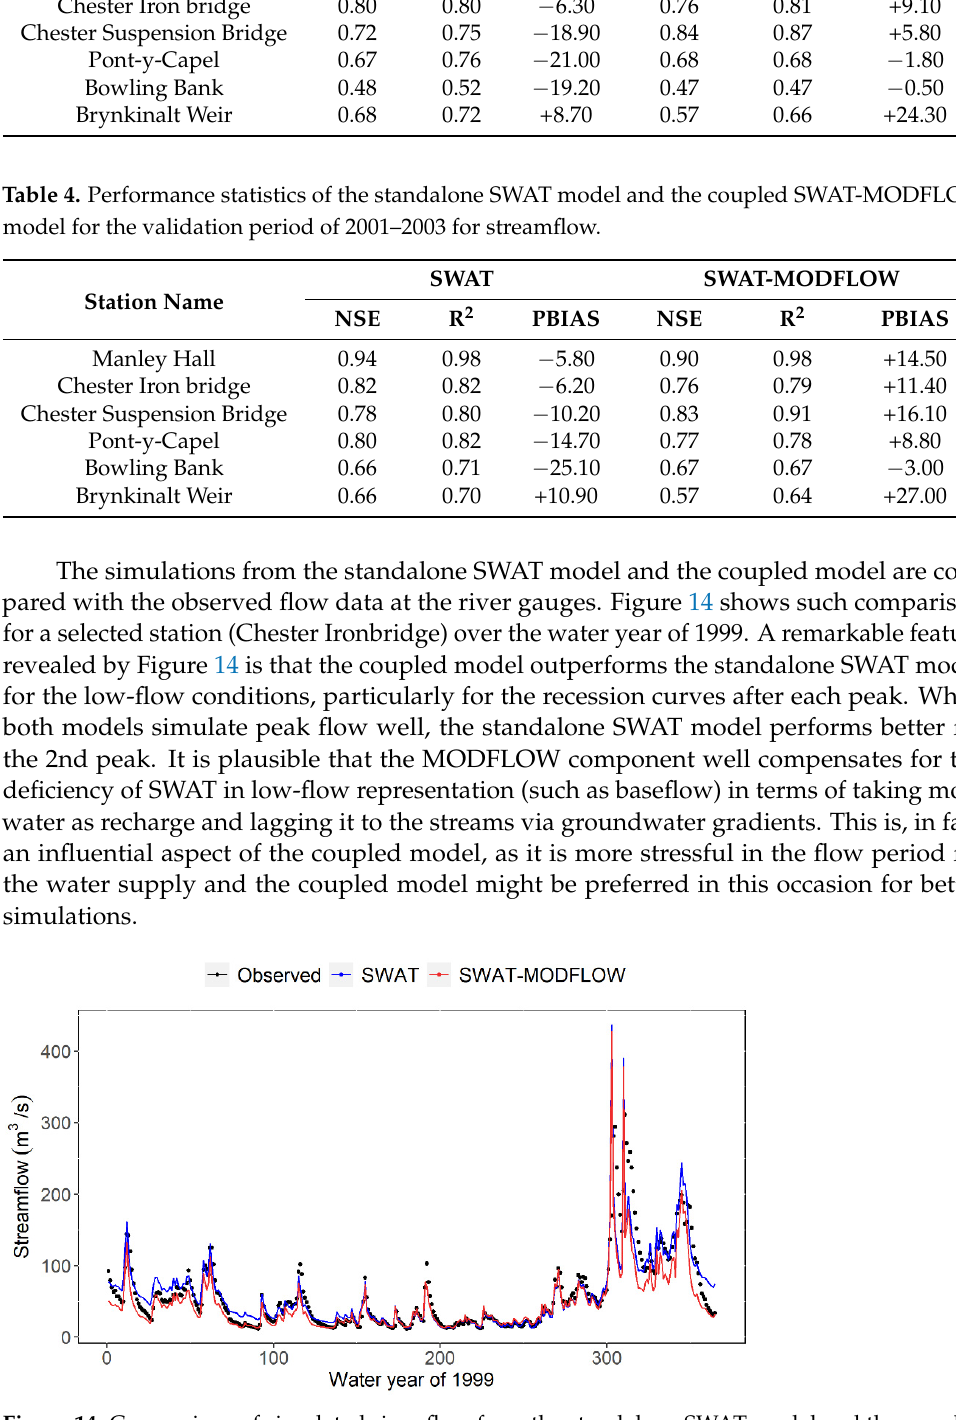
Figure 14. Comparison of simulated river flow from the standalone SWAT model and the coupled SWAT-MODFLOW at Ironbridge for the water year of 1999.